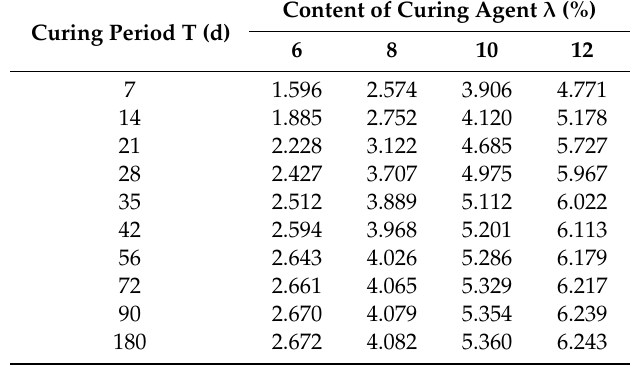
Table 3. The unconfined compressive strength of the solidified calcareous sand (MPa).